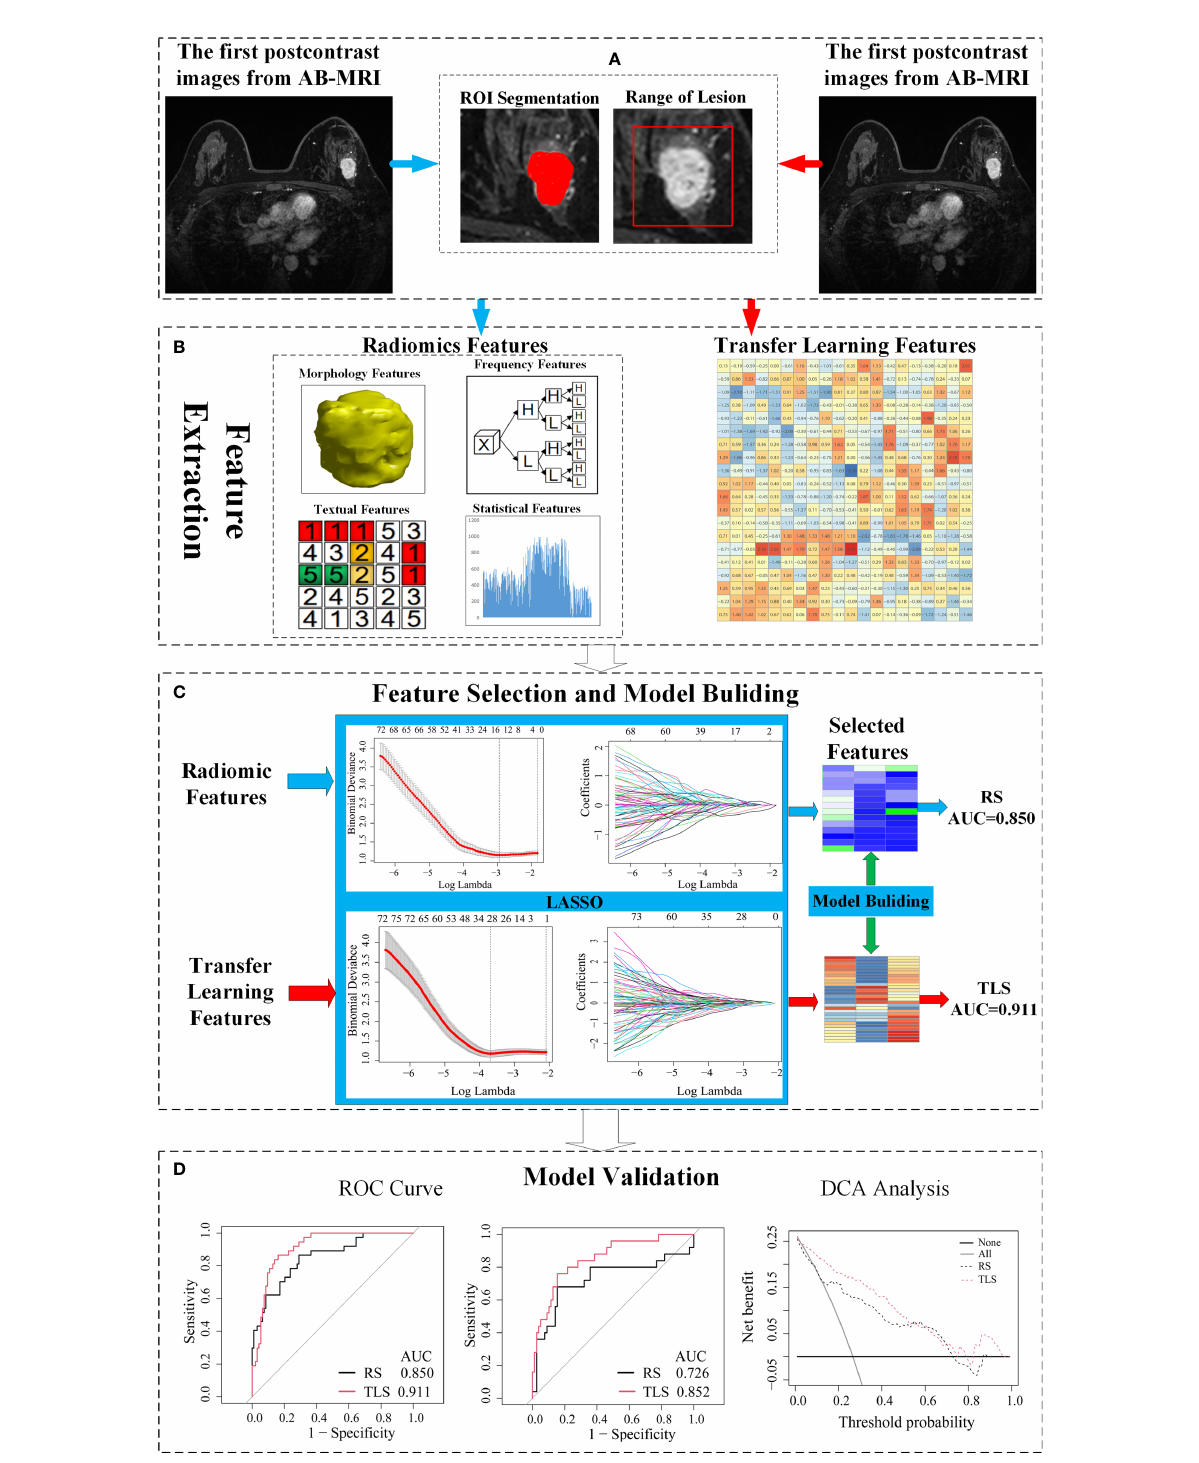
FIGURE 1 Schematic of the study design. (A) The image acquisition and ROI delineation, where the ROI segmentation for radiomics on the left and ROI acquisition for the transfer learning on the right. (B) Radiomics feature and transfer learning feature extraction. (C) Feature selection and a signature building. (D) Independent validation and comparison of models. ROI, region of interest; AB-MRI, abbreviated breast magnetic resonance imaging; LVI, lymphovascular invasion; RS, radiomics signature; TLS, transfer learning signature; ROC, receiver operating characteristics; AUC, area under